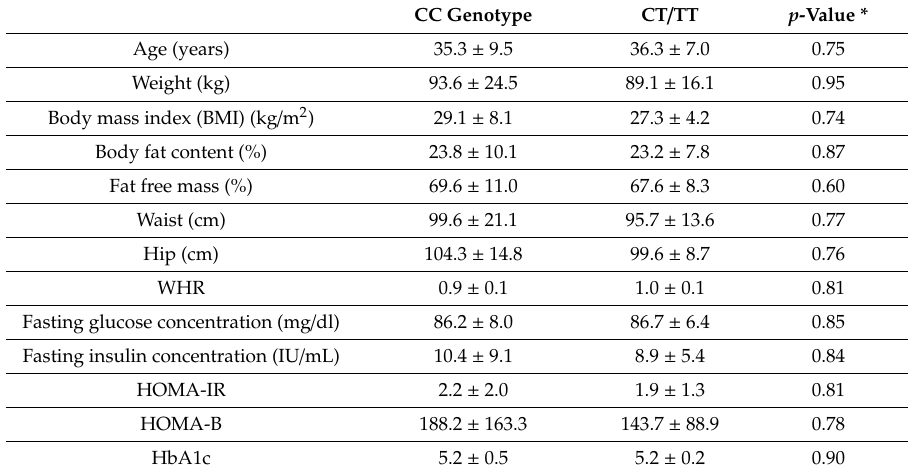
Table 1. The baseline characteristic of studied population by the rs340874 PROX1